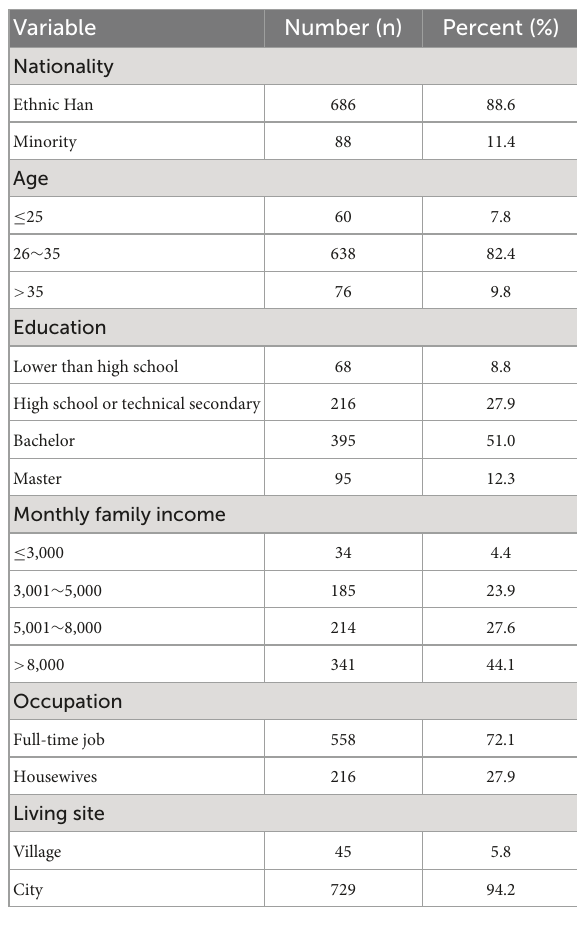
TABLE 1 Demographic characteristics ( N =